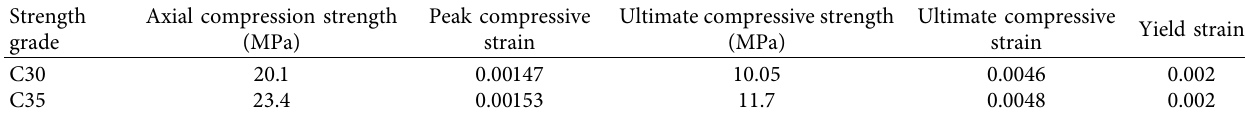
Table 2: Constitutive parameters of concrete in